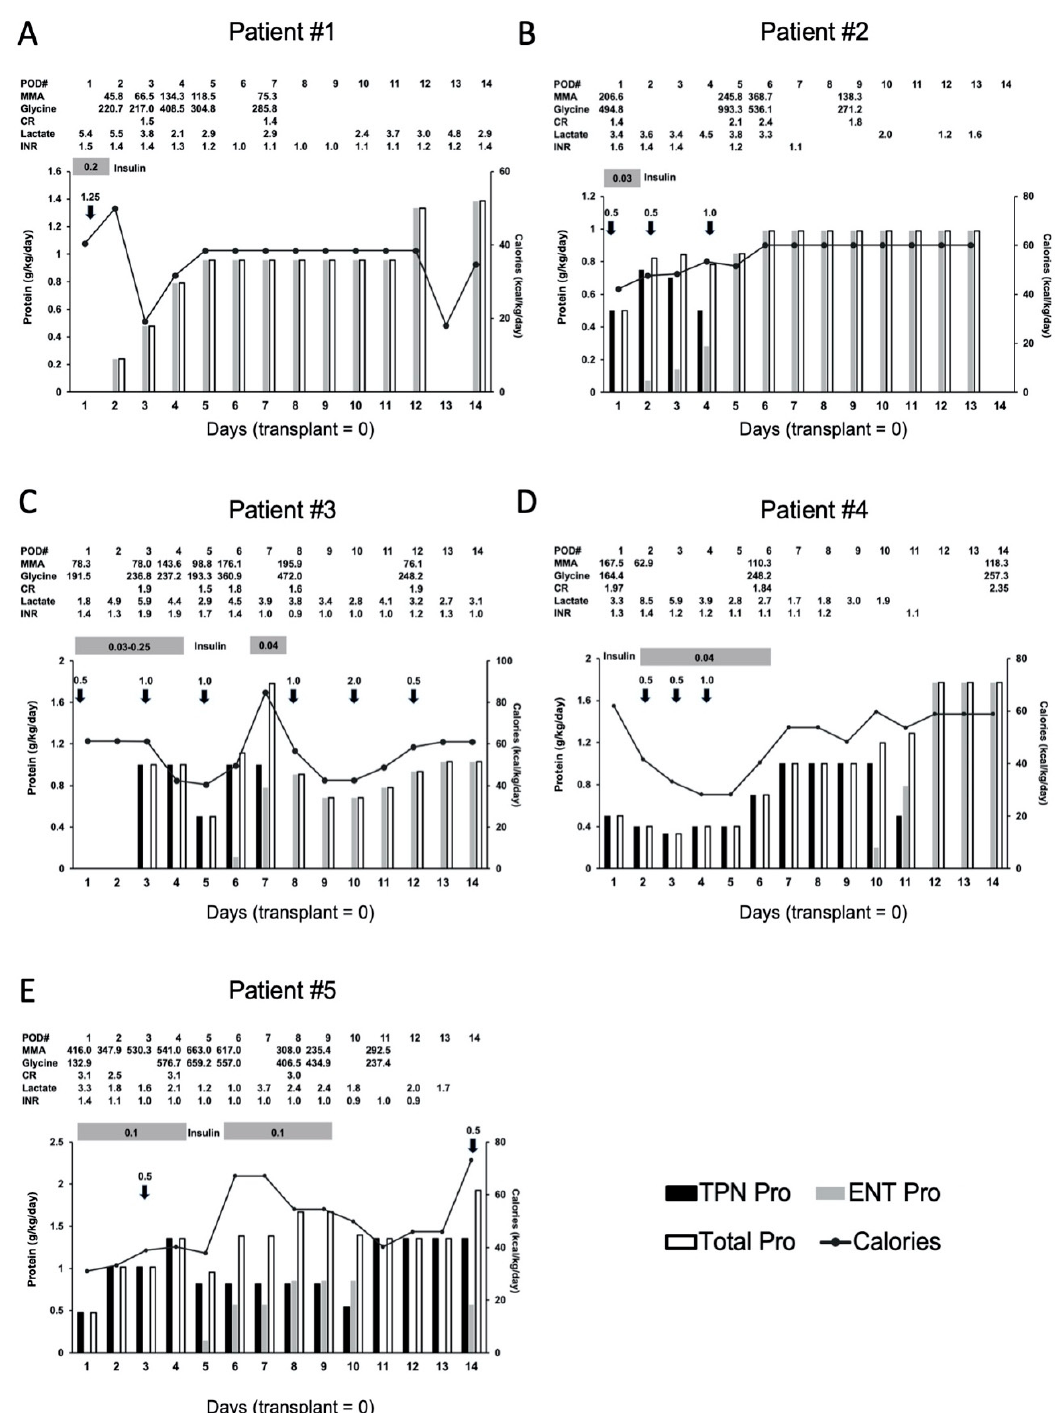
Figure 2. Nutritional management 2 weeks after liver transplant of ( A ) Patient #1, ( B ) Patient #2, ( C ) Patient #3, ( D ) Patient #4, and ( E ) Patient #5. Daily protein (vertical bars) and calorie (black line) intakes are shown. Black vertical bars: protein intake from total parenteral nutrition (TPN) (g / kg / day); grey vertical bars: protein intake from enteral feeding (ENT) (g / kg / day); white vertical bars: total protein intake (Total) (g / kg / day); black arrows: albumin infusion with dose (g / kg / dose); grey horizontal bars; insulin infusion with dose (units / kg / h). Normal ranges and units; plasma MMA = 0–0.4 µ M, glycine = 127–341 µ M, lactate = 0.5–2.2 mM. MMA; methylmalonic acid, CR; plasma total / free carnitine ratio.